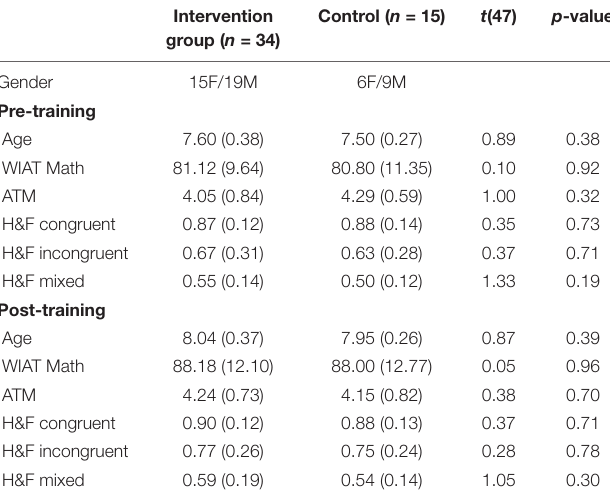
TABLE 2 | Group demographic, academic, and cognitive